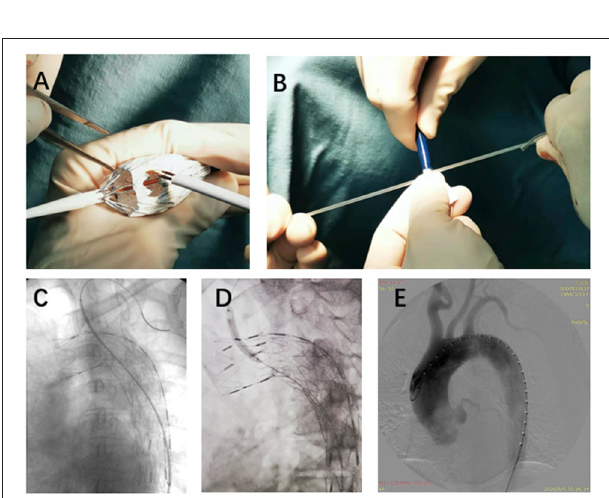
FIGURE 2 | The details of SF-TEVAR procedures. (A) On-table fenestration process. (B) Reloading the stent-graft back into the outer sheath after the fenestration. (C) After delivery of the fenestrated stent-graft, a wire connected the aorta and the LSA (from the same access in femoral artery), and an expandable balloon stent was placed through the fenestration. (D) Inflation of the balloon and deployment of the stent. (E) DSA after the SF-TEVAR procedures. SF, self-radiopaque physician-modified fenestration; TEVAR, thoracic endovascular aortic repair; LSA, left subclavian artery; DSA, digital subtract